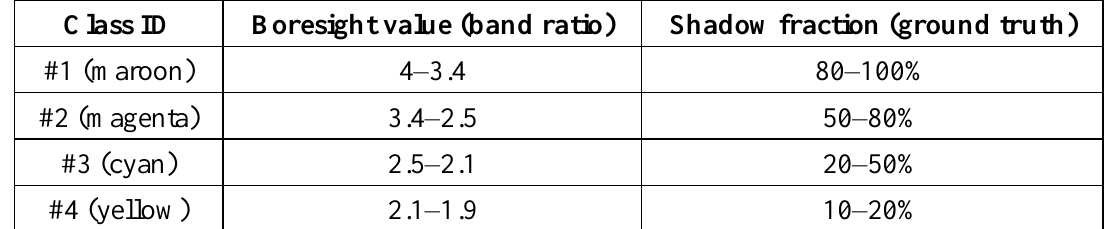
Table 2. Boresight ratio value correspondence to shadow fraction (ground